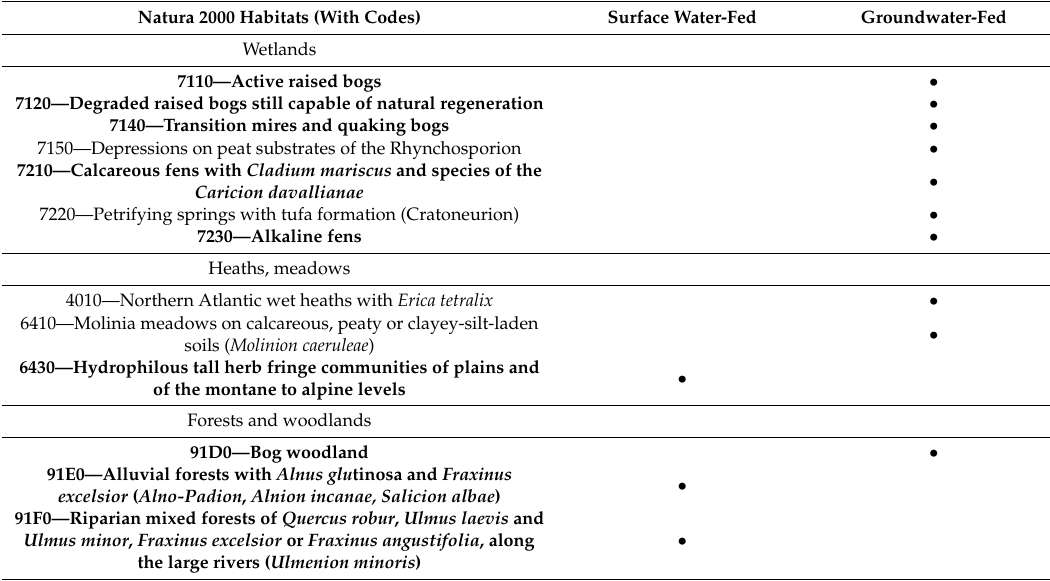
Table 1. The Natura 2000 habitats occurring in Poland and fed by groundwater or surface waters (in bold habitats assessed in this